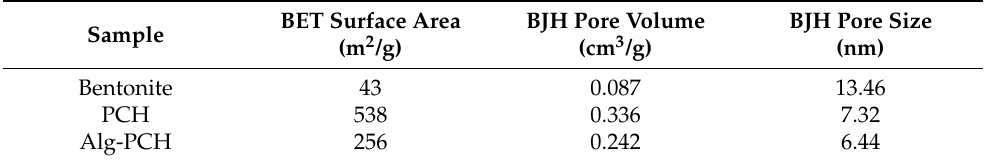
Figure 2. ( A ) N 2 adsorption–desorption hysteresis loop and ( B ) pore volume distribution graph of bentonite, PCH, and Alg-PCH. Table 1. Brunauer–Emmet–Teller (BET) surface area and pore analysis results for bentonite, PCH, and